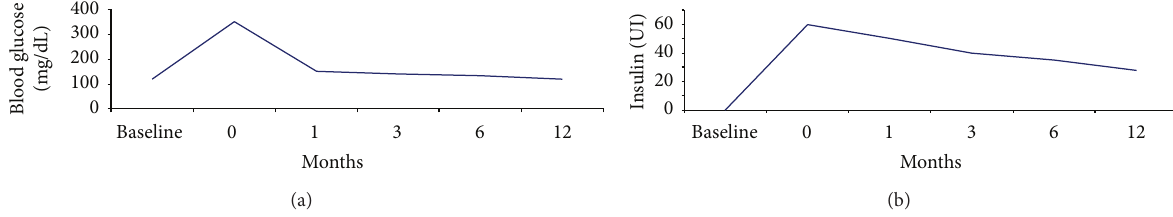
Figure 1: Fast plasma glucose levels and insulin requirement in patients with new-onset diabetes mellitus, measured after and before conversion to sirolimus. The time of conversion was indicated as time 0. Data are expressed as mean